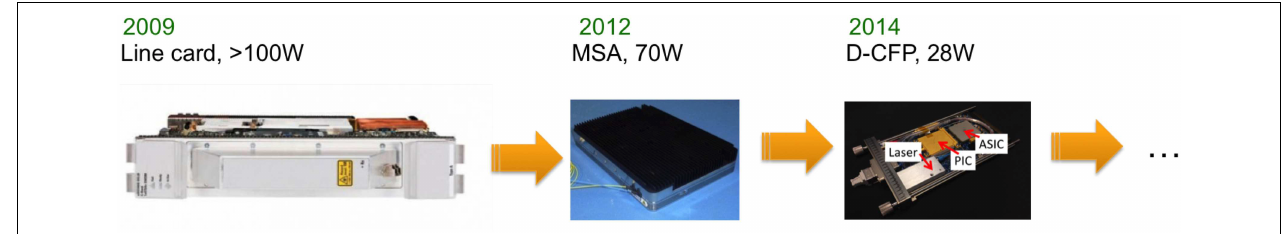
FIGURE 1 | 100-Gb/s coherent transceiver form-factor evolution. It went from a full line card, to a multi-source agreement (MSA) module, to a 100-Gb/s form-factor pluggable (CFP) module. The D in D-CFP means that it is a digital module and the DSP is included inside, as opposed to a module that contains only the optics.